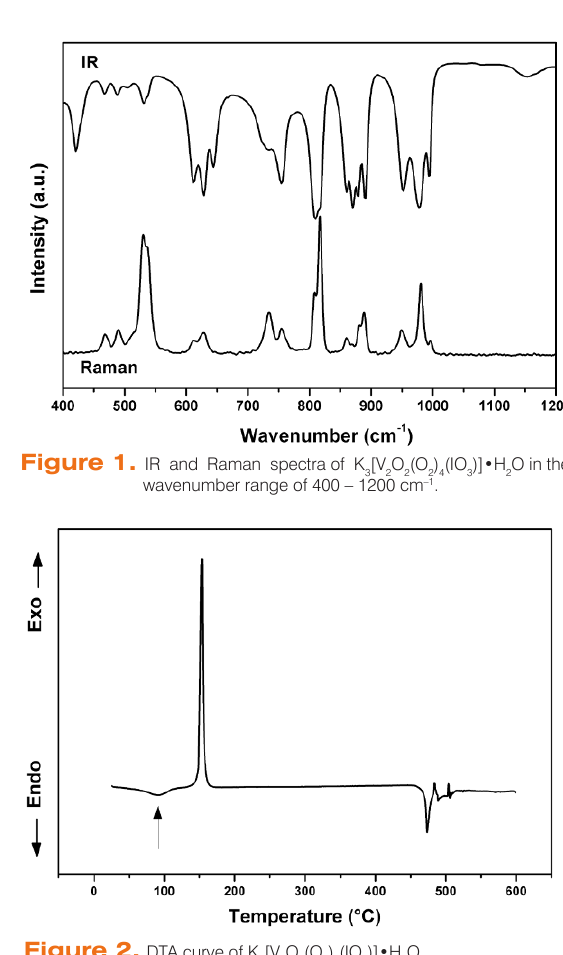
[V O (O ) (IO )]•H 3 2 2 2 4 3